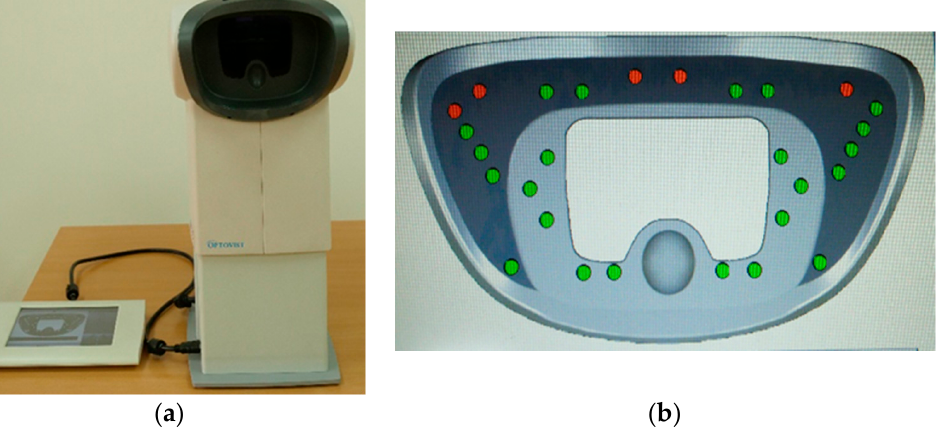
Figure 1. ( a ) Vision-screening instrument (ortoreter); ( b ) test preview on ortoreter (red dots—unregistered visual stimuli by participant; green dots—registered visual stimuli by participant).